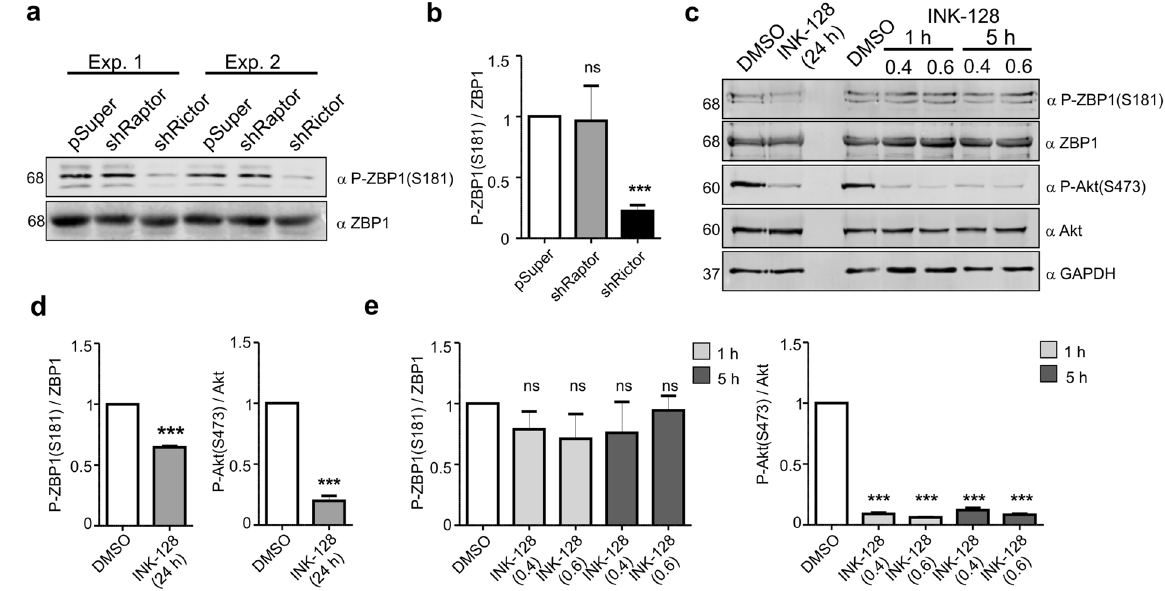
Figure 1. ZBP1 is phosphorylated at Ser181 in neurons in an mTORC2-dependent manner. ( a ) Western blot analysis of levels of ZBP1 phosphorylated at Ser181 (P-ZBP1[S181]) and total ZBP1 in protein lysates obtained from DIV8 neurons nucleofected on DIV0 with empty pSuper (control vector) or pSuper that encoded shRNA against Raptor or Rictor. Cropped blots are presented (for full length blots see Supplementary Information). ( b ) Results of quantitative Western blot analysis. The data are presented as a ratio of the signal intensity of P-ZBP1(S181) to the signal intensity of ZBP1 ± SEM. *** p < 0.001, ns - non significant (One sample t -test). Number of independent experiments ( N = 4). ( c ) Western blot analysis of levels of P-ZBP1(S181), total ZBP1, P-Akt(S473) and total Akt in protein lysates obtained from DIV10 neurons treated for 1, 5 or 24 h with vehicle (DMSO) or INK128 at indicated concentrations. GAPDH is shown as an additional loading control. Cropped blots are presented (for full length blots see Supplementary Information). ( d ) Results of quantitative Western blot analysis. The data are presented as a ratio of the signal intensity of P-ZBP1(S181) to ZBP1 or P-Akt to Akt ± SEM. *** p < 0.001, ns - non significant (One sample t -test). Number of independent experiments ( N =